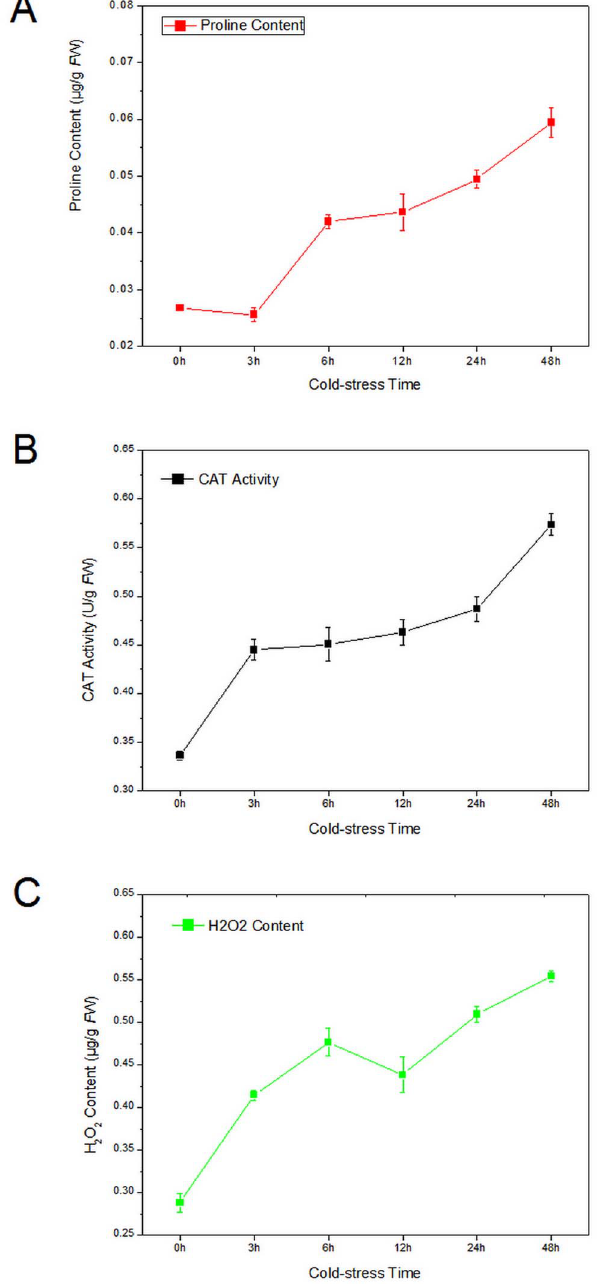
Figure 1. Changes in proline content (A), CAT activity (B) and H 2 O 2 content (C) under low temperature (4 6 C) treatment over time.